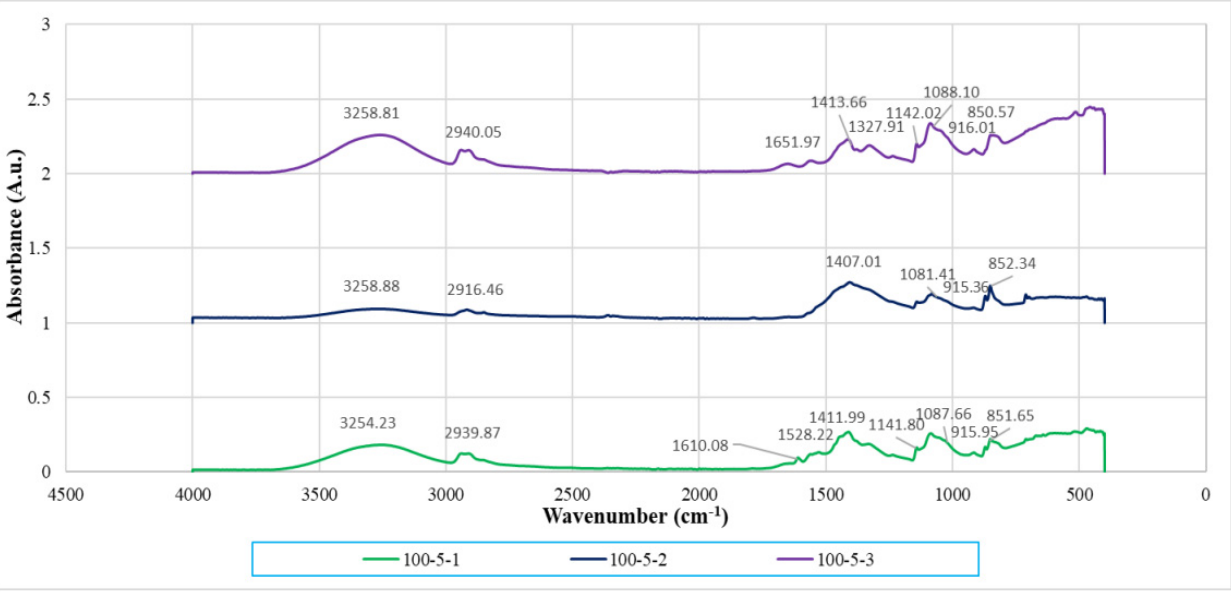
Figure 6. Infrared spectrum of PVOH-MMT nanocomposite added with 5 phr calcined cuttlebone. Note: 100-5-1 denotes 100 phr PVOH added with 5 phr cuttlebone and 1 phr MMT. Table 2. Wavenumbers of its stretching type for all PVOH-calcined cuttlebone-MMT composites.